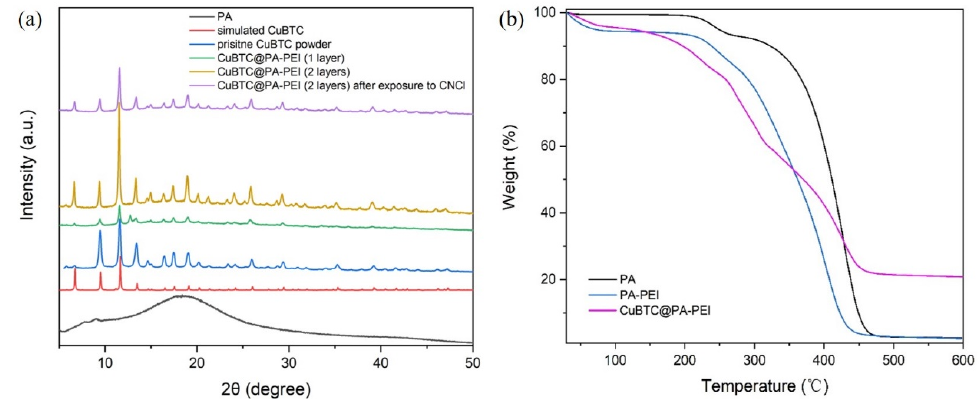
Figure 4. ( a ) The XRD patterns of PA matrix, CuBTC@PA-PEI (1 layer), CuBTC@PA-PEI (2 layers), simulated CuBTC, and CuBTC@PA-PEI after exposure to CNCl; ( b ) TGA curves of PA matrix, PA-PEI, and CuBTC@PA-PEI.